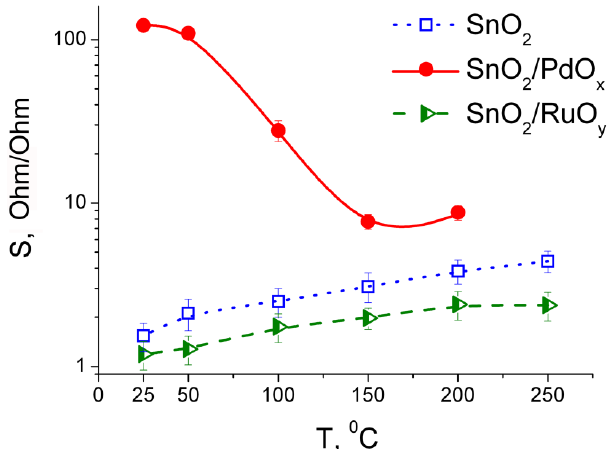
Figure 5. Temperature dependence of sensor signals of nanocrystalline SnO 2 , SnO 2 /PdO x , and SnO 2 /RuO y samples to 50 ppm CO.